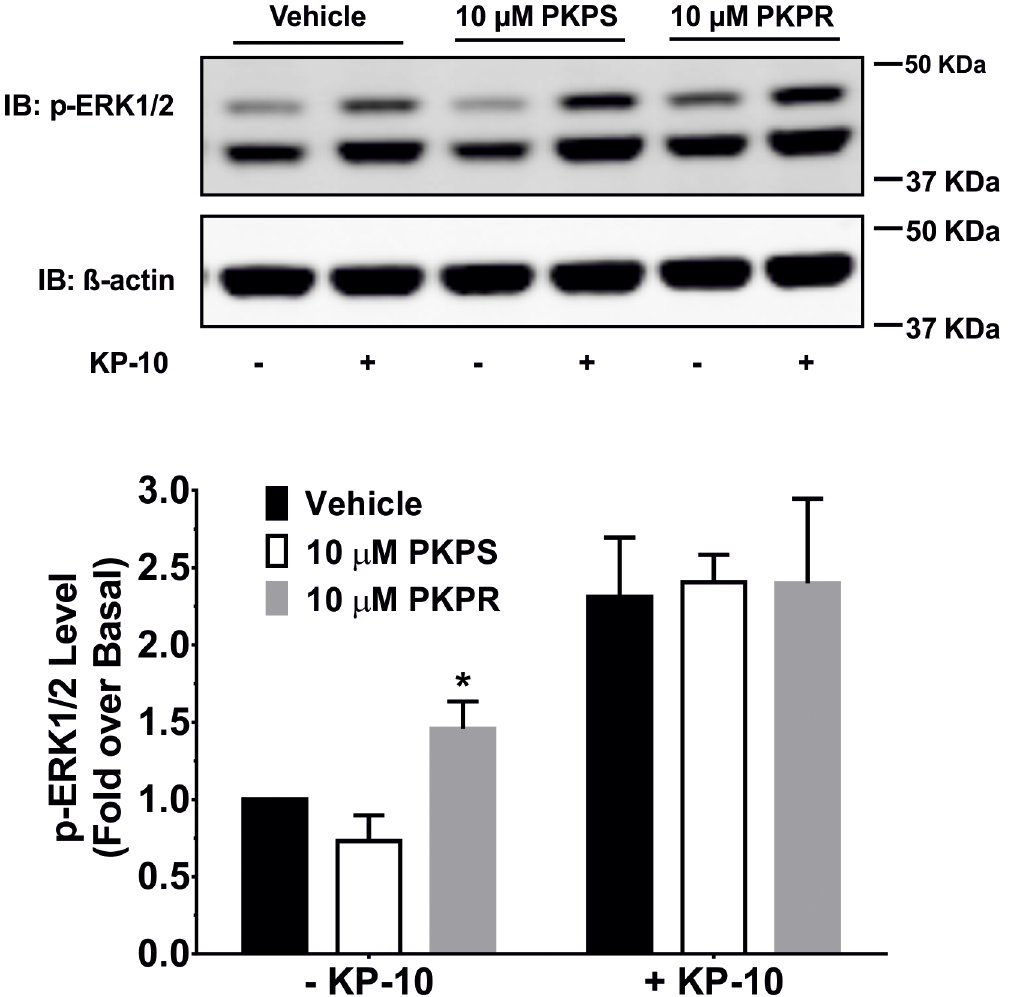
Fig 4. Effect of PKPS and PKPR on KP-10-induced phosphorylation of ERK1/2. MCF-7 cells transiently expressing kisspeptin receptor were serum-starved for 20 hours. The cells were then treated with vehicle (0.02% (v/v) DMSO; black bars), 10 μM PKPS (white bars) or PKPR (grey bars) for 30 minutes. After that, vehicle (0.02% (v/v) propylene glycol, labelled–KP- 10) or 100 nM KP-10 (labelled + KP-10) was added for a further 10-minute stimulation. Western blot analyses were carried out using monoclonal anti-phospho-ERK1/2 and anti- β -actin antibodies. Representative western blot (upper) and densitometric quantitation (bottom) are shown. The data represent the mean fold-changes over the basal treated with vehicle ± SD of three independent experiments. (cid:3) , P < 0.05, compared with the basal treated with vehicle.